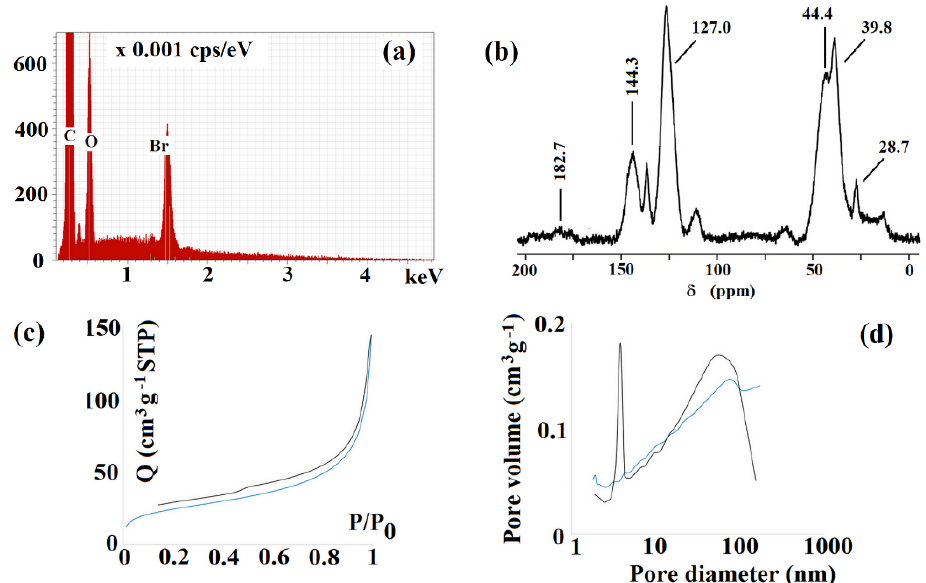
Figure 4. EDS spectrum of MIP ft before hydrolysis of the amide linkage ( a ), 13 C CP MAS NMR spectrum for MIP ft ( b ), nitrogen-sorption hysteresis ( c ) and pore-size distributions ( d ) for MIP ft after hydrolysis of amide linkage.